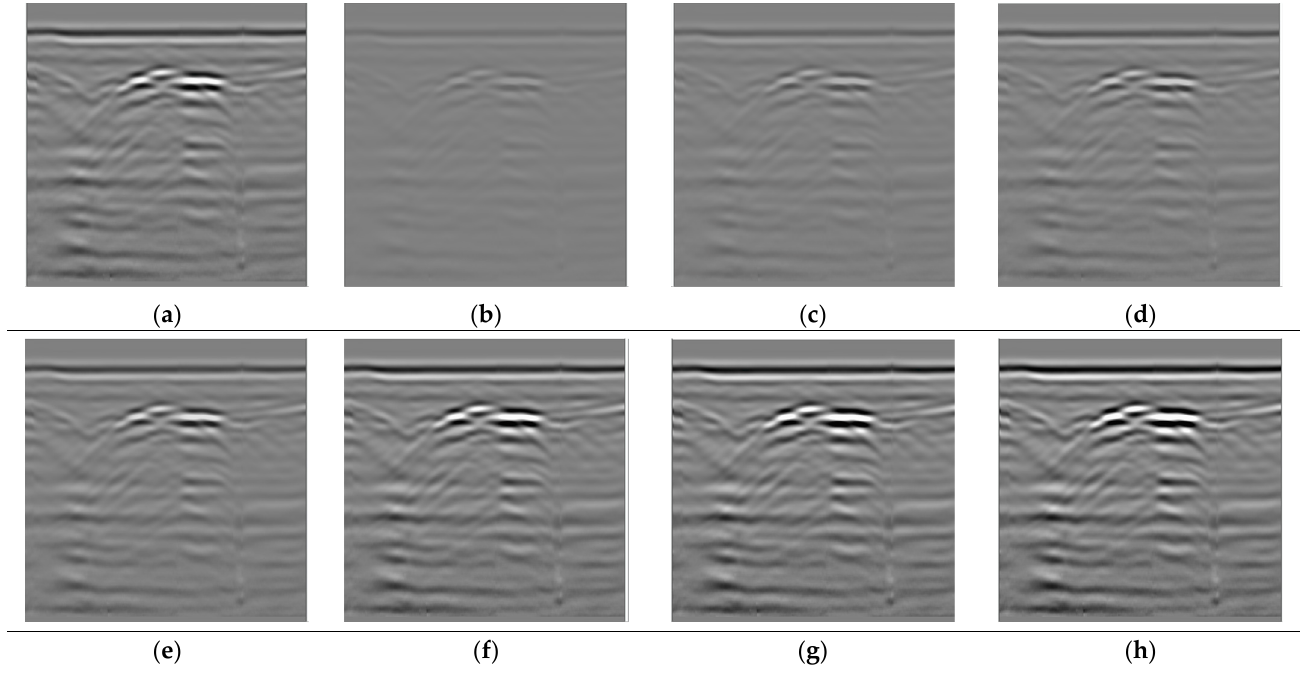
Figure 2. ( a ) The original GPR image; ( b – h ) are the GPR images that were generated with 0.2,